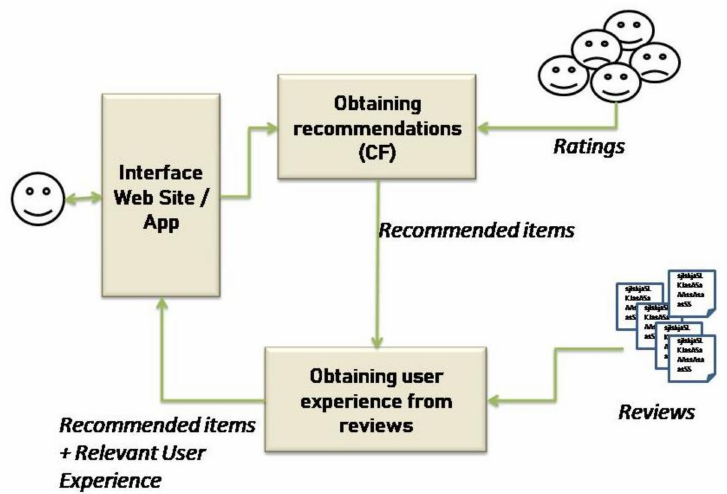
Figure 1. Recommending items and sentences containing relevant user